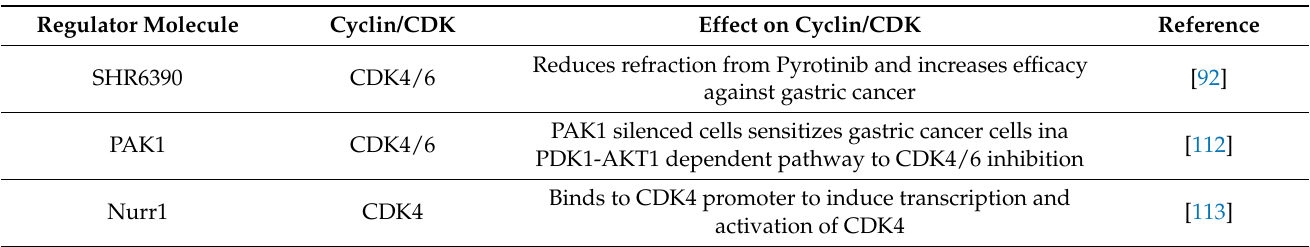
Table 3. The regulators of CDK4/6 investigated in the context of gastric cancer are given. (Note: UAP1L1 is a downstream target of